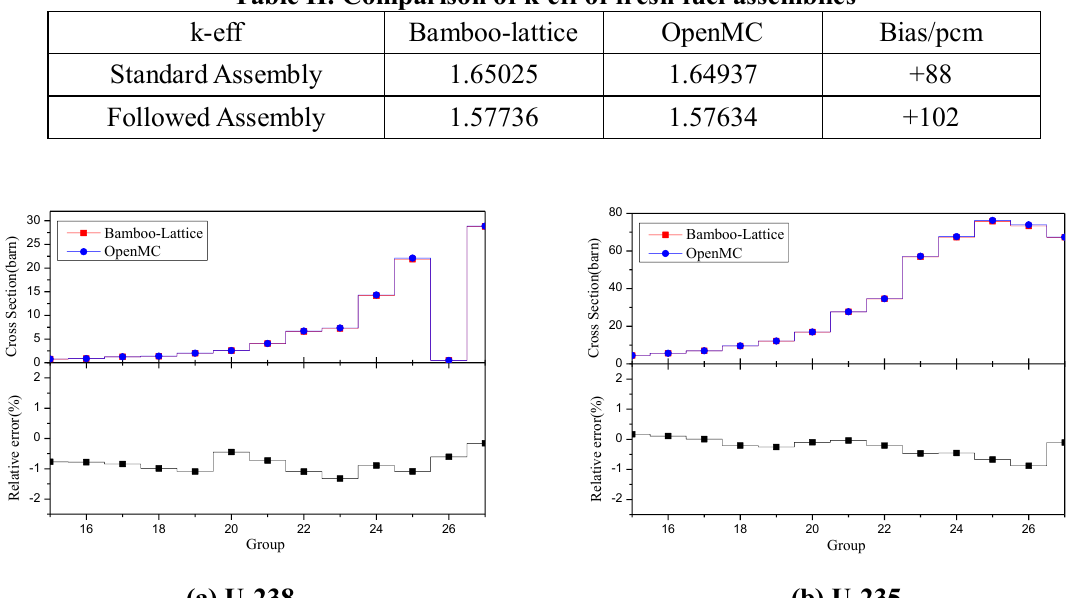
Figure 2. Comparison of the resonance absorption cross-sections for Standard Assembly